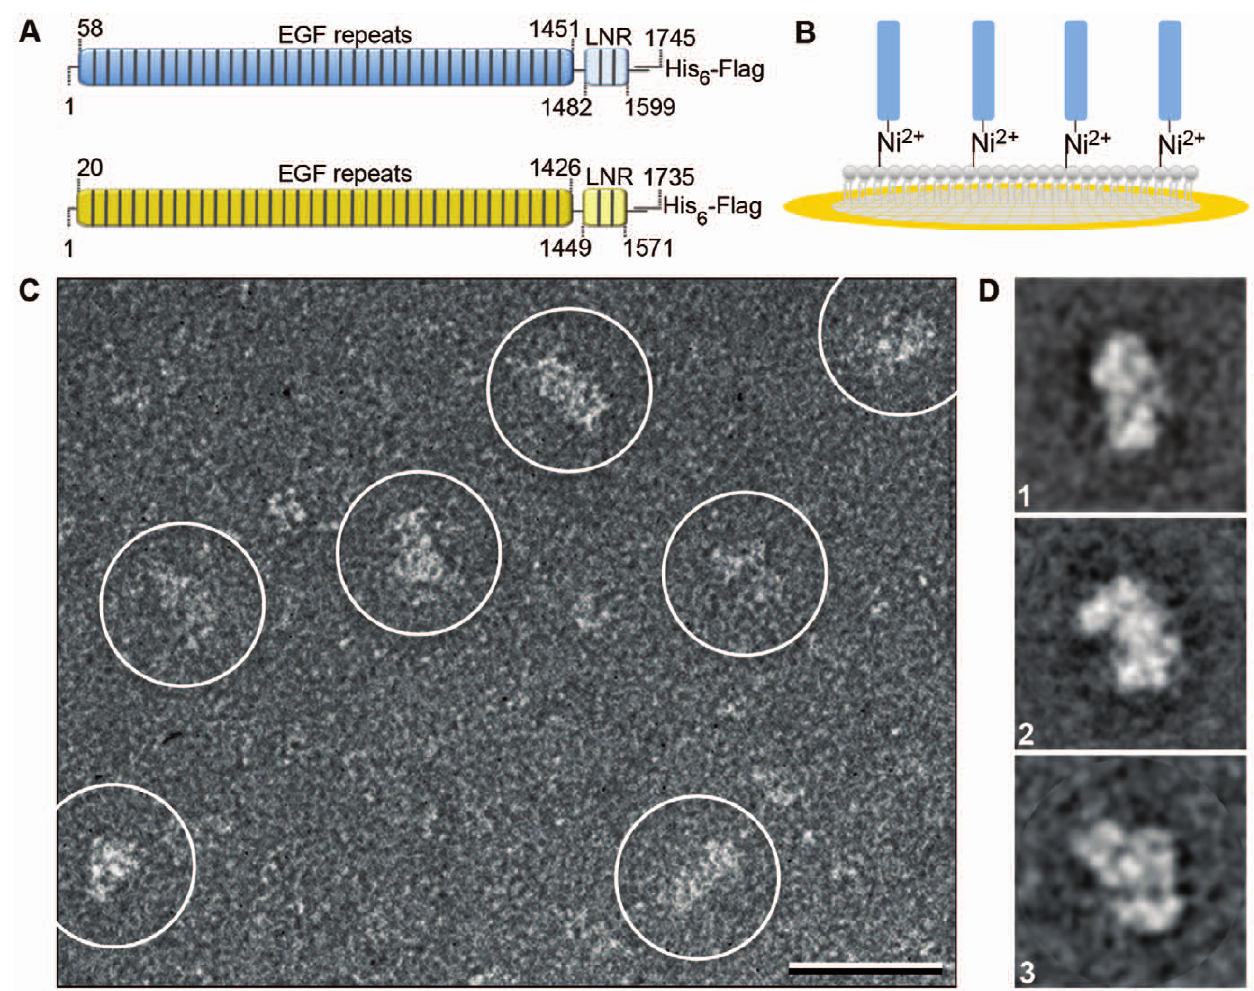
Figure 1. EM of the NECD. ( A ) Constructs used of the Drosophila (blue, residues 1–1745) and human (yellow, residues 1–1735) NECDs contained 36-EGF repeats (residues 58–1451, Drosophila and 20–1426, human) followed by 3-LNR motifs (residues 1482–1599, Drosophila and 1426–1571, human) and a C-terminal tandem Flag-His 6 tag. ( B ) Schematic drawing of an Affinity Grid, which features a pre-deposited lipid monolayer. The lipid monolayer contains Ni-NTA lipids that can recruit His-tagged NECD. ( C ) Raw image of negatively stained Drosophila NECD (marked by white circles; scale bar is 25 nm) and ( D ) representative class averages (side length of the individual panels is 43 nm).